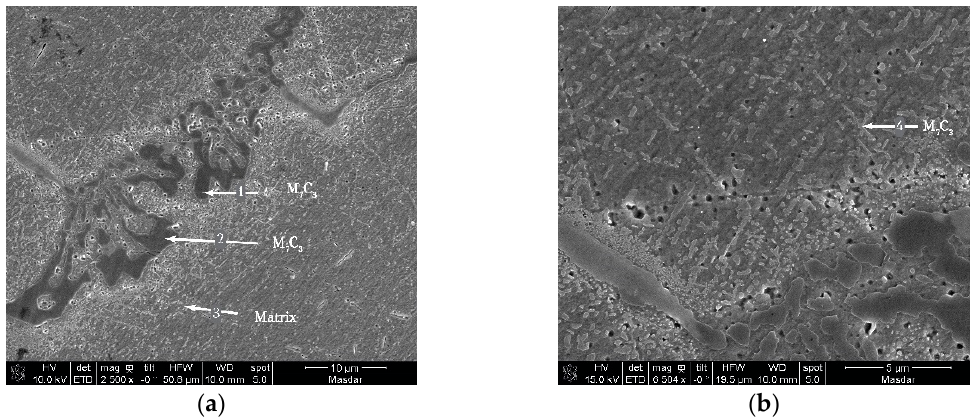
Figure 4. SEM image depicting M 7 C 3 carbides in condition L. ( a ) “Chinese script” morphology; ( b ) needle morphology. Numbers indicate EDX composition analysis in Table 2.